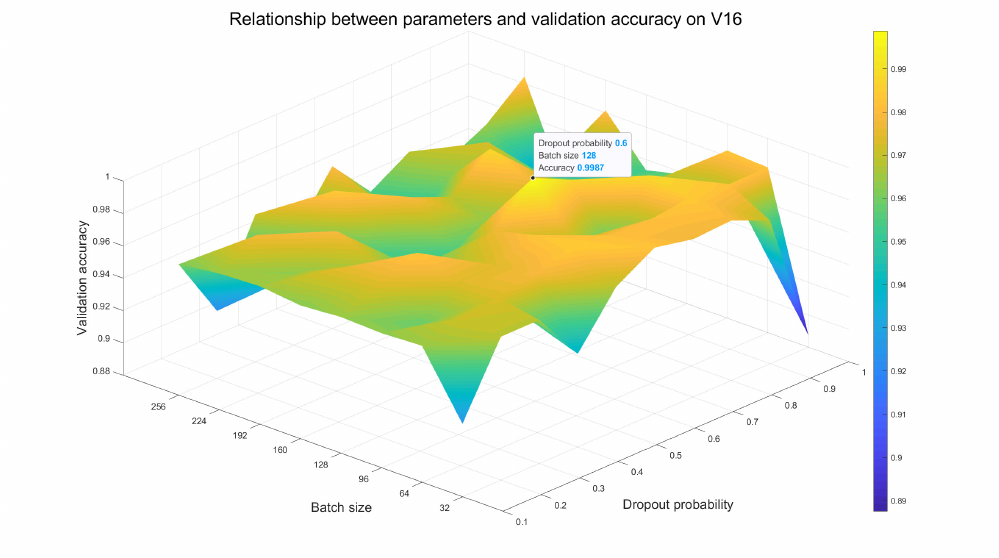
Figure 13. Surface plot on the V16 model displaying the resulting validation recognition accuracy for different choices of values of the batch size and the dropout